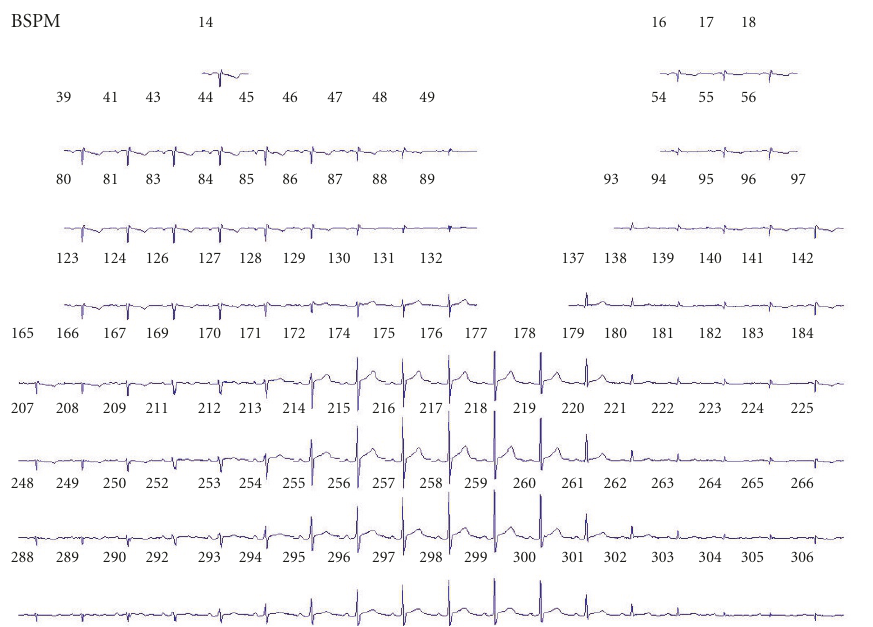
Figure 13: Data matrix D i with one beat from a BSPM recording. The signal from lead l is plotted around the torso location where the sensing electrode is located. The torso is displayed in an unfolded format, the right subplot corresponds to the back, the left one to the front, and the middle hole corresponds to the left axile.